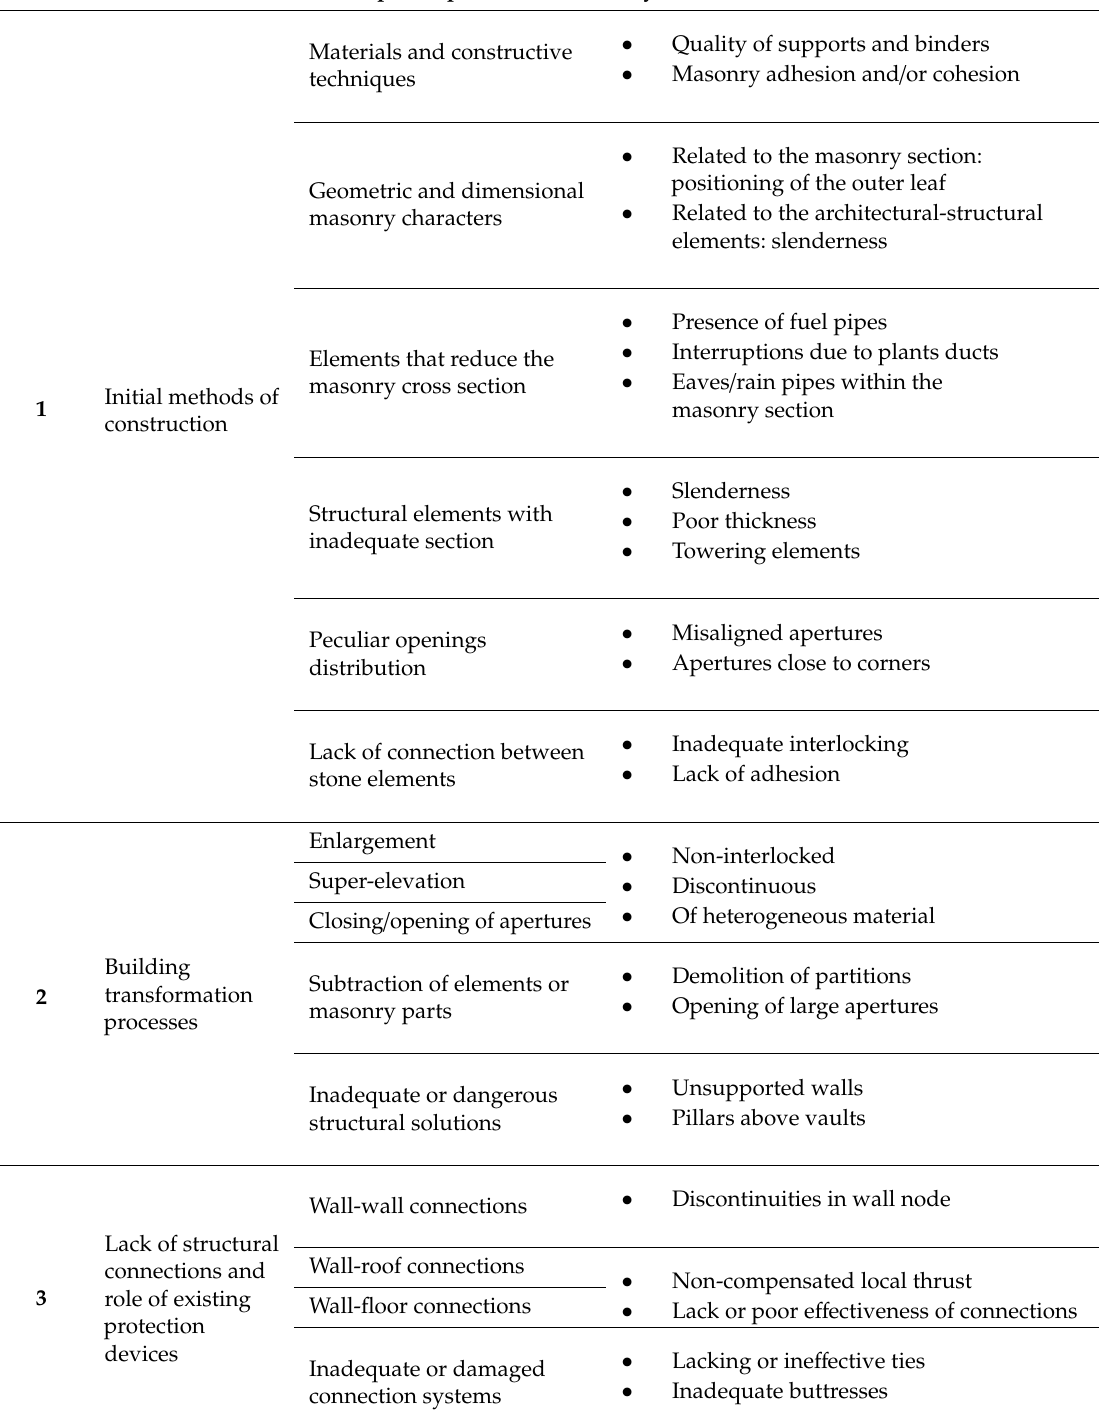
Table 4. Classification of specific vulnerability forms in thematic groups attributed to six di ff erent possible